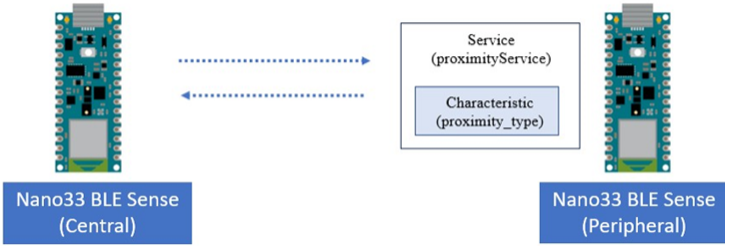
Figure 4. BLE communication between two Arduino Nano 33 BLE Sense